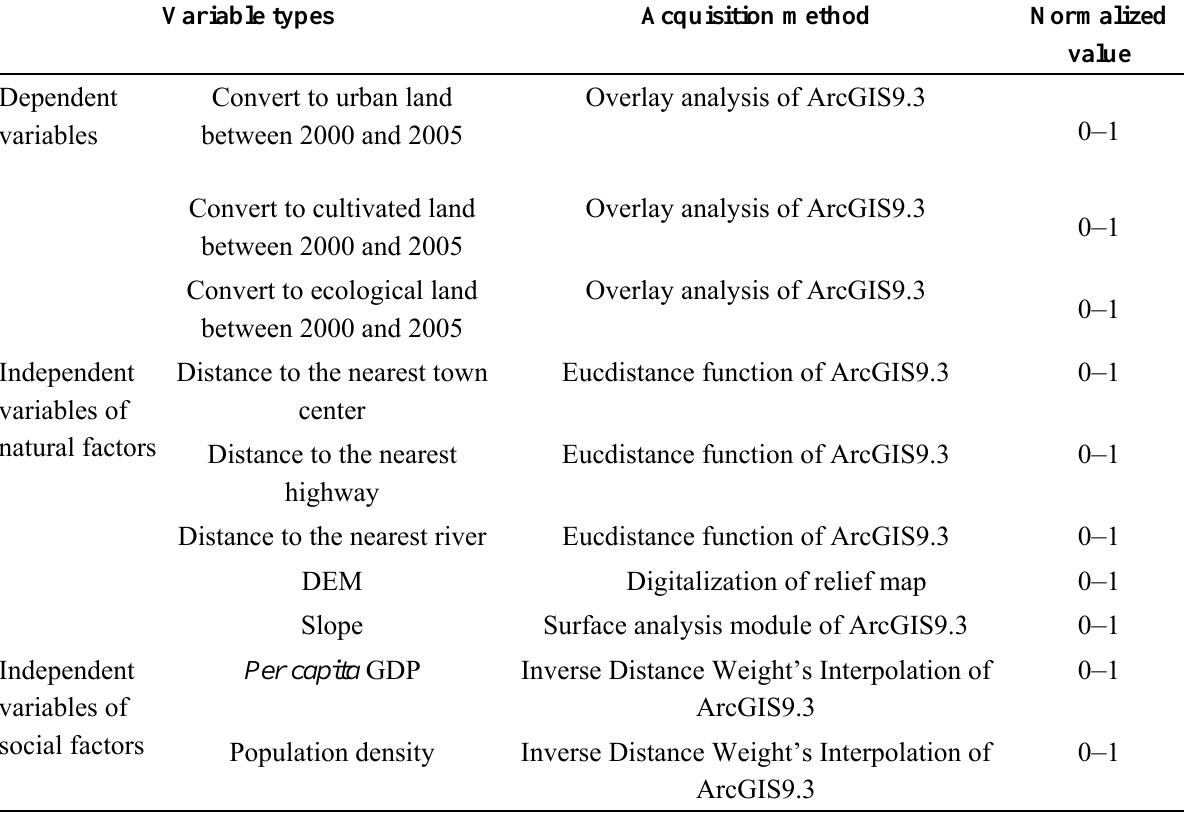
Table 2. Spatial variables needed by finding translation rules for the logistic regression